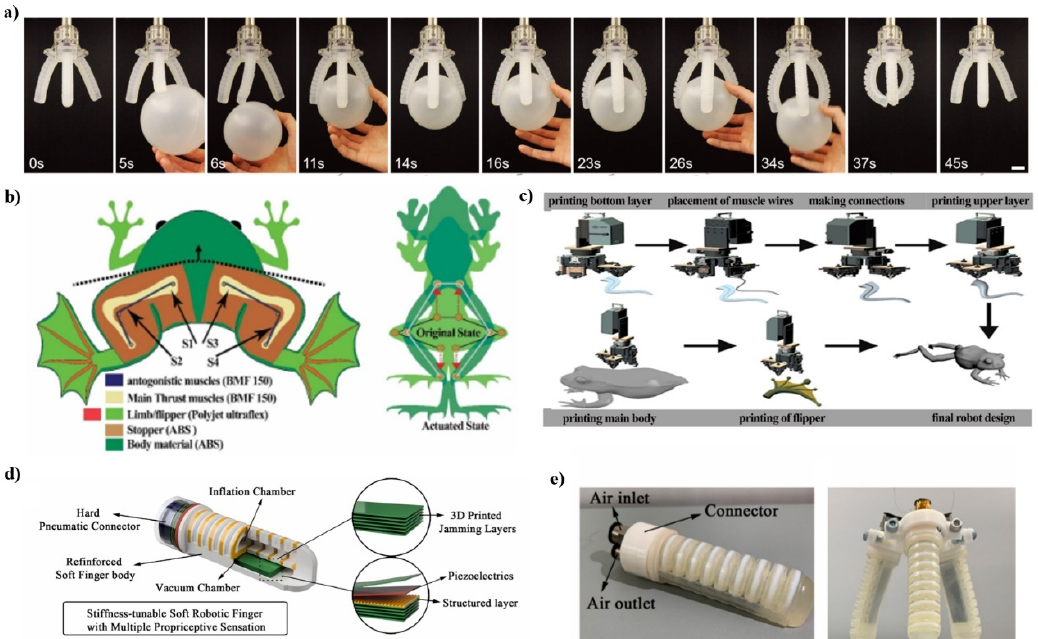
Figure 3. ( a ) Images of an interaction process between a ball and a soft robotic gripper comprised of SSAs. Reproduced with permission from ref. [57]. Copyright 2018, John Wiley and Sons. ( b ) Schematic diagram of the working mechanism; the left image shows the dual method of generating thrust, and the right image shows synchronized swimming. Reproduced with permission from ref.